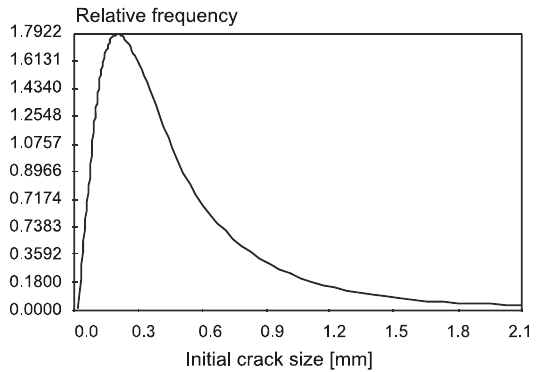
Fig. 8. Lognormal density function of initial crack size